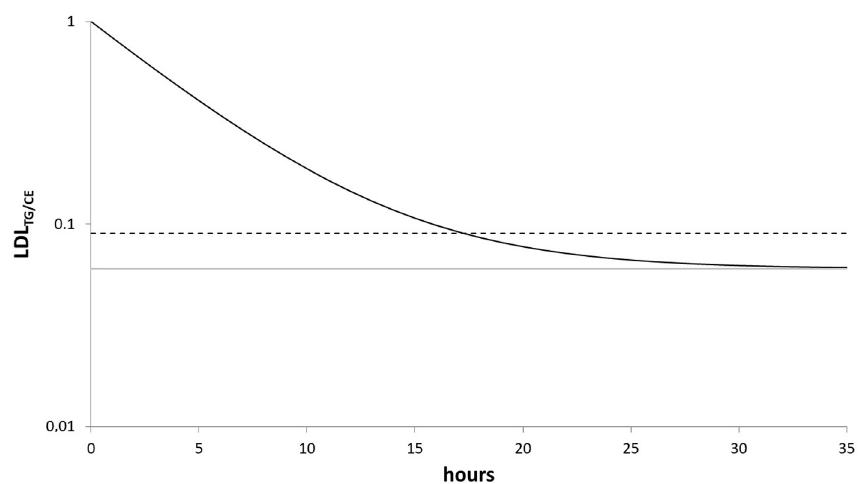
Fig 1. Sketch of the model. Black solid line: exemplary trajectory of the TG/CE ratio of a hypothetical LDL particle � � with infinite retention time in plasma LDL TG . The ratio decreases exponentially with rate r. Grey line: The t ð Þ � � CE . Dashed line: the observed molar TG/CE ratio in LDL LDL TG corresponding asymptote Min TG CE of the TG/CE ratio of all present LDL